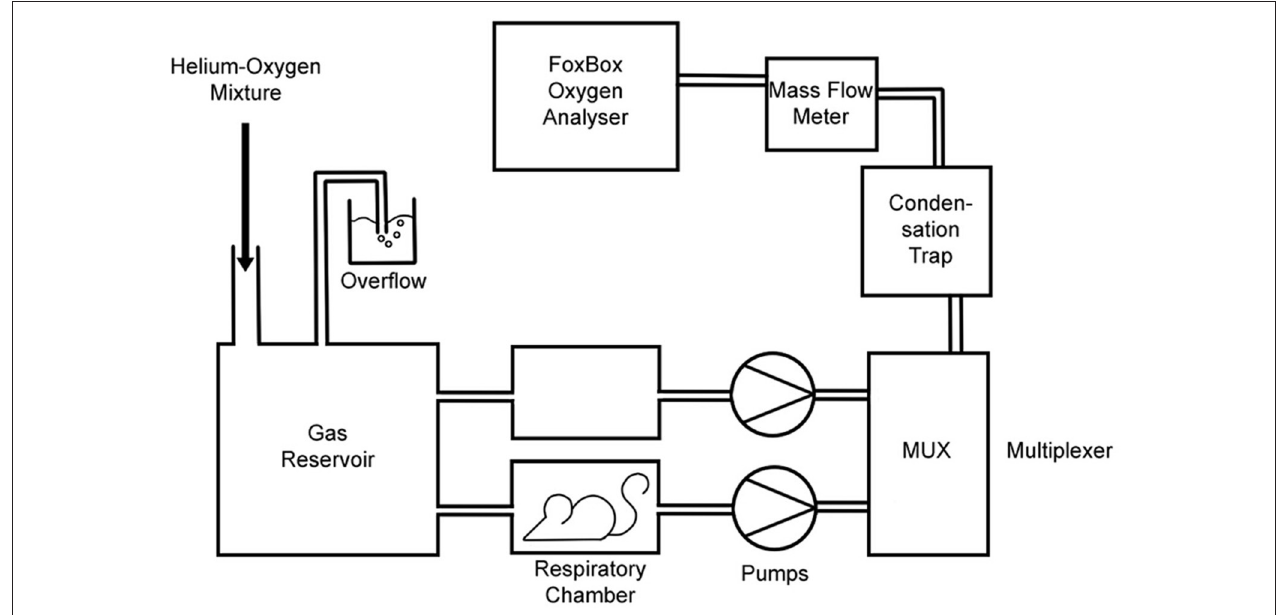
FIGURE 1 | Experimental set-up for measurement of maximal oxygen consumption. Pumps draw gas from the gas reservoir through the respiratory chambers and from there via the multiplexer through a water condensation trap and through the flow meter into the oxygen analyzer. For ˙ V O2 , max determination, the gas reservoir contains 21% oxygen/rest He, and the gas reservoir and respiratory chambers are placed into a cold room at 4 ◦ C. For resting ˙ VO2 determination, the gas reservoir contains air, and the entire set-up is placed in room air at 21 ◦ C. The empty chamber serves as a control of the inspiratory gas. Usually a third respiratory box was mounted in parallel to the two boxes shown, containing another animal. In this case, the three boxes contained a WT mouse, a KO mouse and no animal, respectively. The gas coming from the empty box was used as a reference gas indicating the O 2 concentration in the gas